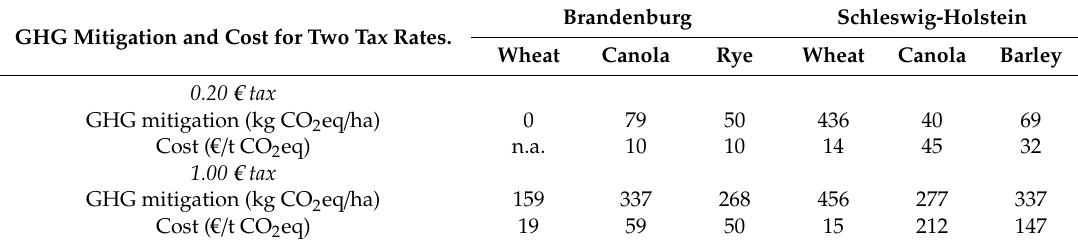
Table 1. Greenhouse gas (GHG) mitigation and mitigation cost with a tax of 0.20 and 1.00 € per kg N